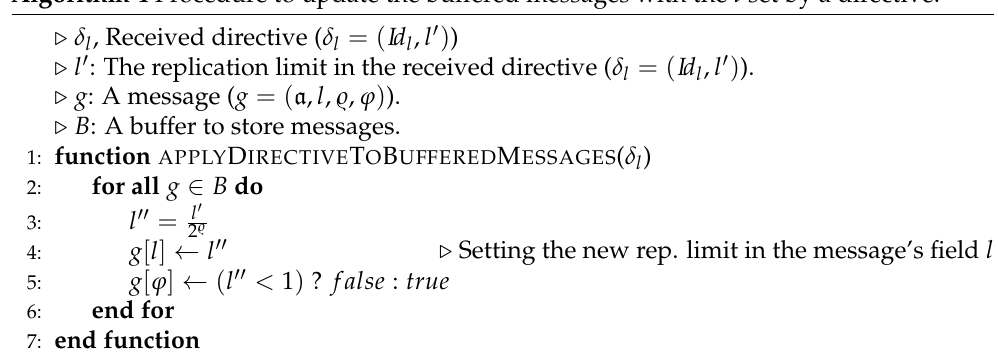
Algorithm 4 Procedure to update the buffered messages with the l set by a